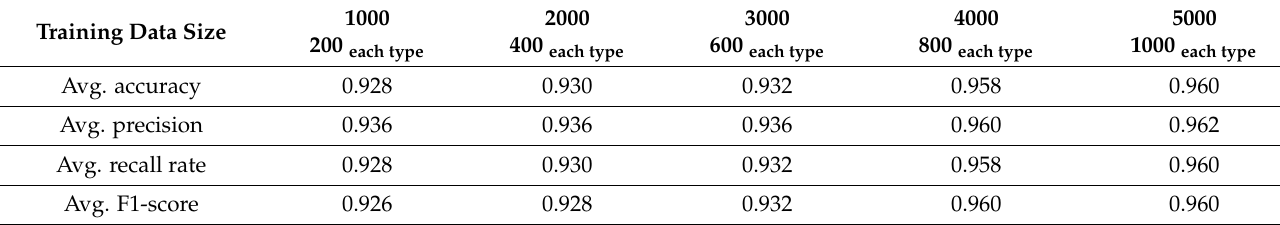
Table 7. Inception results.